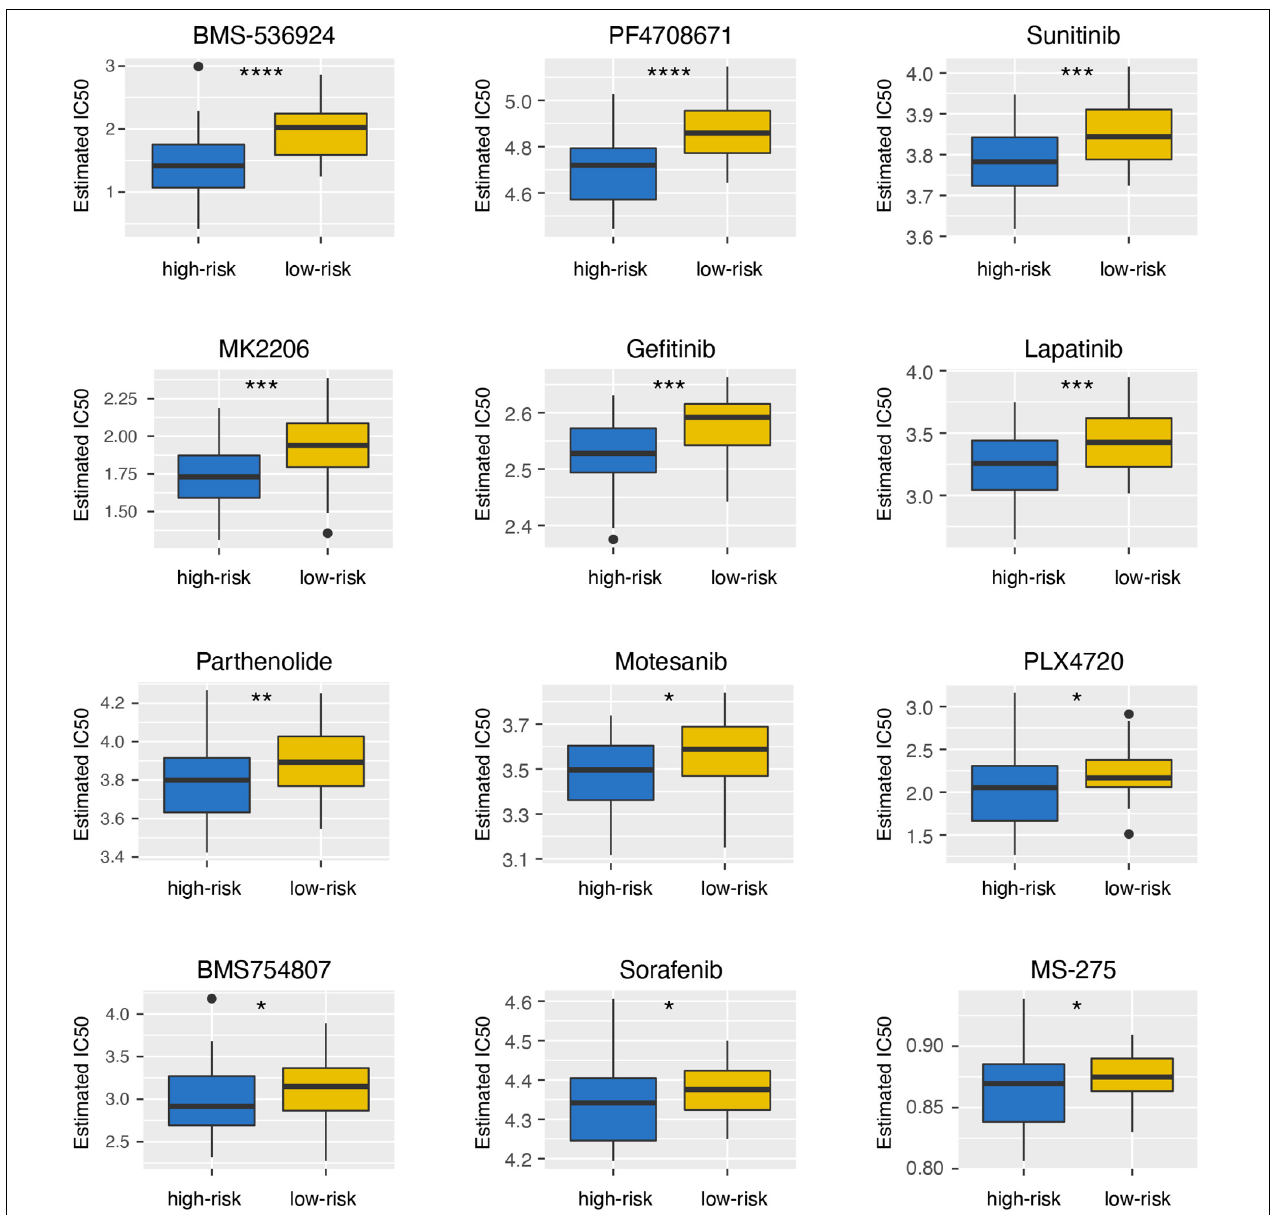
FIGURE 6 | Differential sensitivity to drugs between the high- and low-risk groups. * p < 0.05; ** p < 0.01; *** p < 0.001; and **** p < 0.0001.